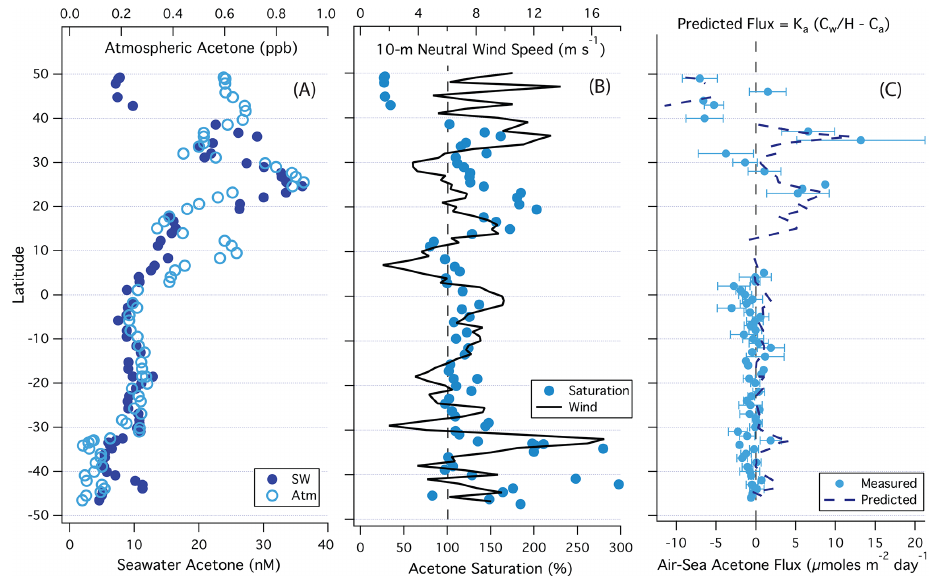
Figure 6. (A) Atmospheric and seawater ( ∼ 5m depth) concentrations of acetone; (B) saturation of acetone and wind speed; (C) flux measured by EC and predicted with the two-layer